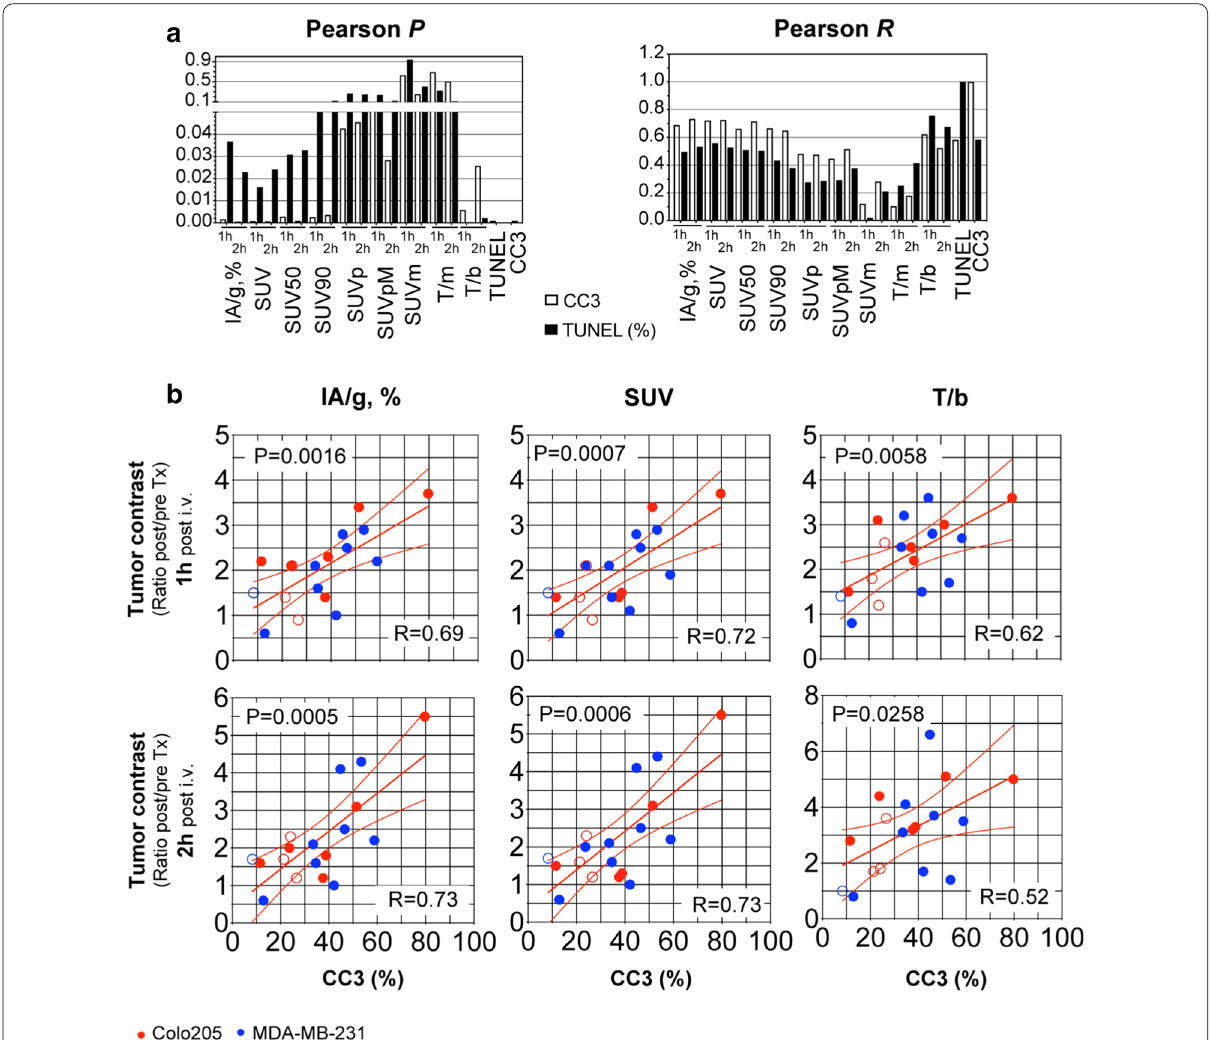
Fig. 7 Pearson correlation analysis of tumor PET signal with histological markers of cell death. a Pearson P (left) and R (right) correlation values for tumor signal, expressed as different contrast metrics, 1 h and 2 h post‑administration of 18 F‑C2Am, with cell death markers (CC3, open bars, or TUNEL, closed bars) estimated from two sections (200 µm apart) from the same tumors, from both Colo205 and MDA‑MB‑231 models. ( b ) Pearson correlation analysis of tumor contrast, expressed as IA/g, % (left), SUV (middle) and T/b ratio (right), 1 h (top row) or 2 h (lower row) after 18 F‑C2Am administration, with tumor cell death (CC3, %). Tumor contrast is expressed as the signal ratio, post/pre‑treatment. Pooled data ( a, b ) from Colo205 ( n 9, red symbols) and MDA‑MB‑231 ( n 9, blue symbols) tumor‑bearing mice, treated with MEDI3039 (0.1 or 0.4 mg/kg, 24 h, i.v., filled symbols), = = 5FU (Colo205, 100 mg/kg, i.p., 24 h, open red symbols) or doxorubicin (MDA‑MB‑231, 100 mg/kg, i.p., 24 h, open blue symbols). Two‑tailed, Pearson P and R values are shown ( a ). CC3 cleaved caspase 3, TUNEL terminal deoxynucleotidyl transferase‑mediated dUTP nick‑end labeling.